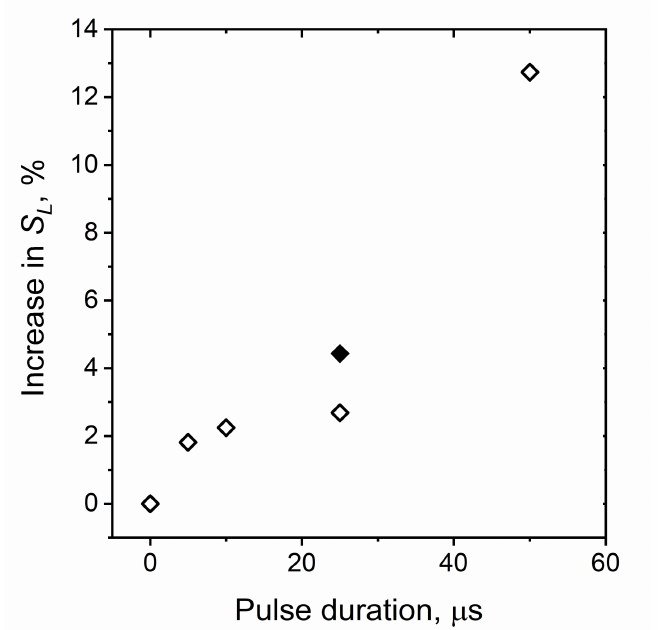
Figure 7. Percent increase in laminar burning velocity as a function of pulse duration for flames at φ = 0.7. Electric field strength is E RMS = 350 kV/m (open symbols) and E RMS = 370 kV/m (filled symbol).